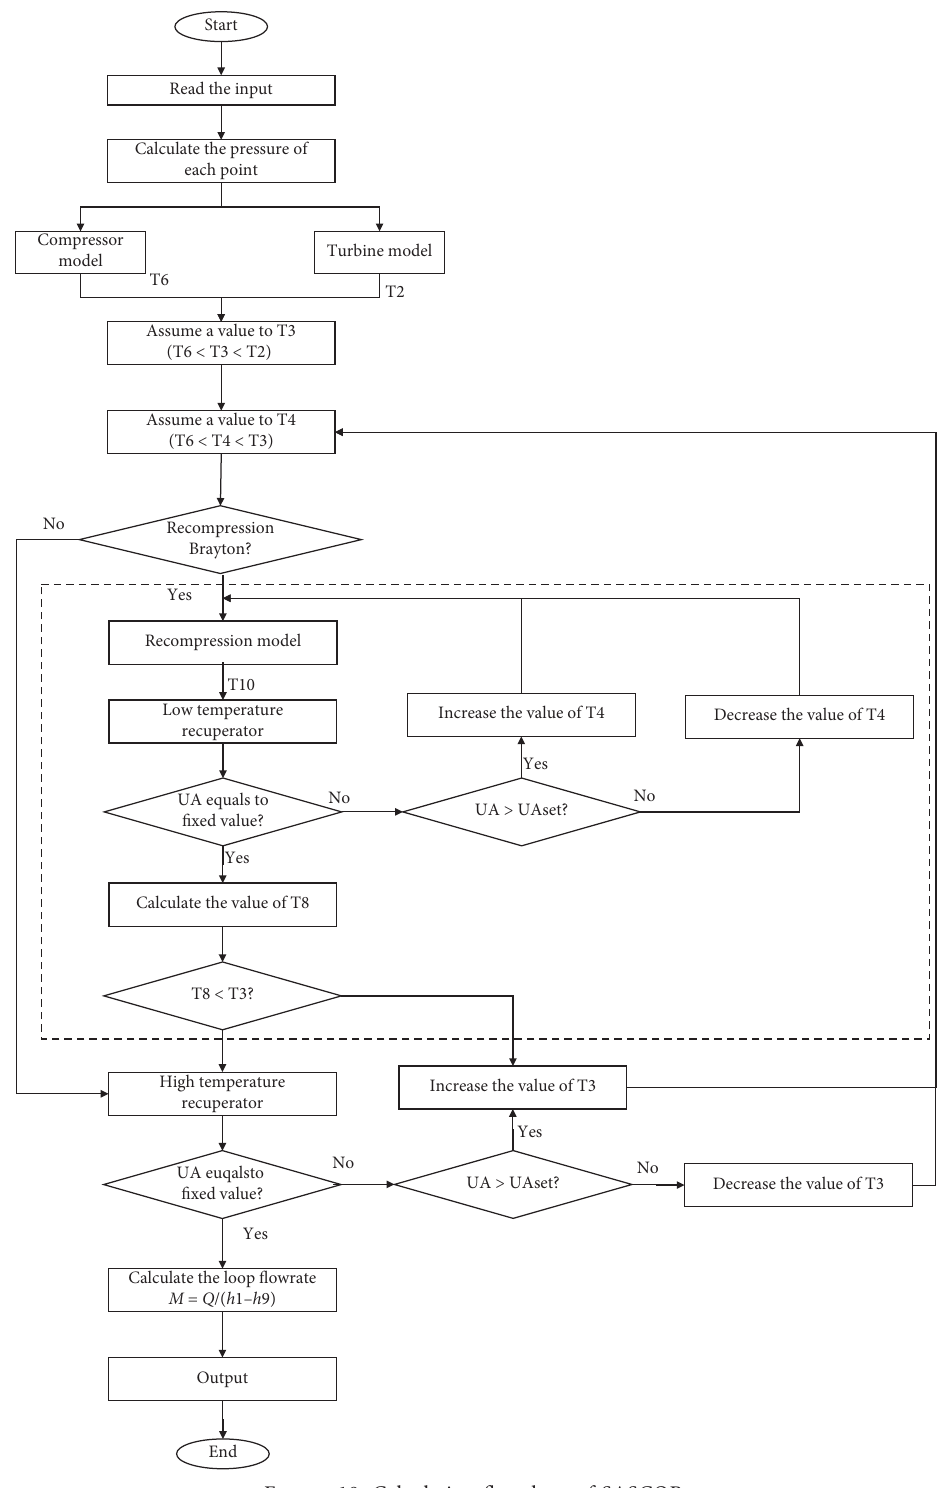
Figure 18: Calculation flowchart of